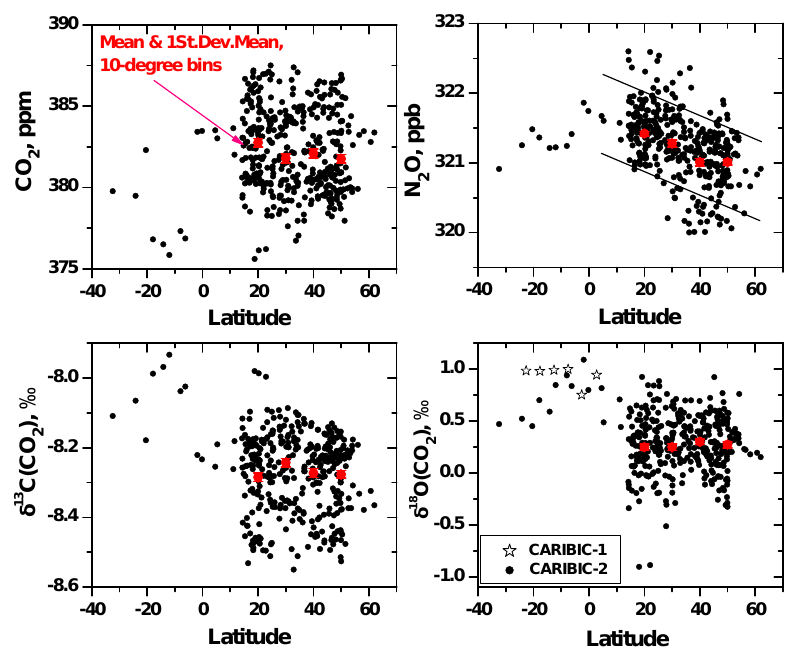
Fig. 8. Latitudinal distributions of CO 2 , N 2 O and isotope data for CARIBIC-2, flights from April 2007 to March 2009 (de-trended data). Only tropospheric samples from CARIBIC-2 (separated by N 2 O > 320.0ppb) and tropospheric δ 18 O(CO 2 ) values of CARIBIC-1 in the SH are shown. Shown in red are Mean values in 10-degree bands, the error bars (close to symbol size) correspond to 1Std.Dev. of the Mean. Data from CARIBIC-1 for SH air samples are shown for